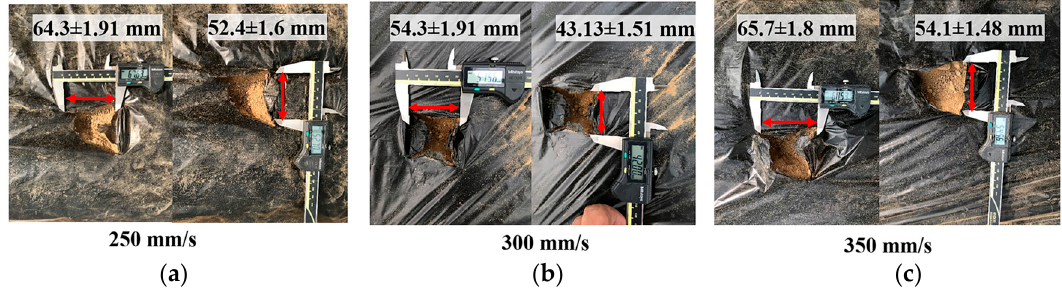
Figure 10. Mulch film damage during 250 ( a ), 300 ( b ), and 350 mm/s ( c ) forward speeds of transplanting operations.